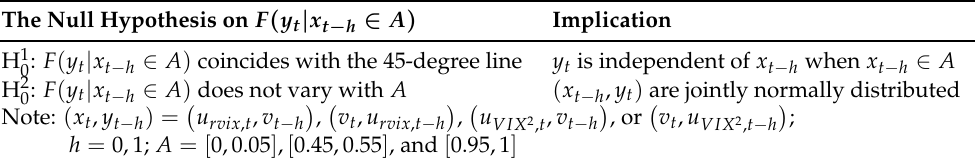
Table 4. The Hypotheses of Interest.